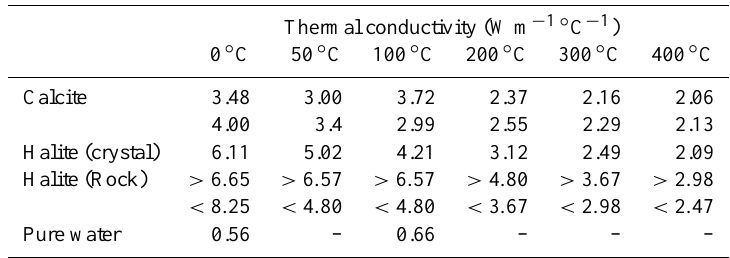
Table 3. Thermal conductivity of calcite, halite and pure water at 0, 50, 100, 200, 300 and 400 ◦ C, after Clark (1966) and Clauser and Huenges (1995).